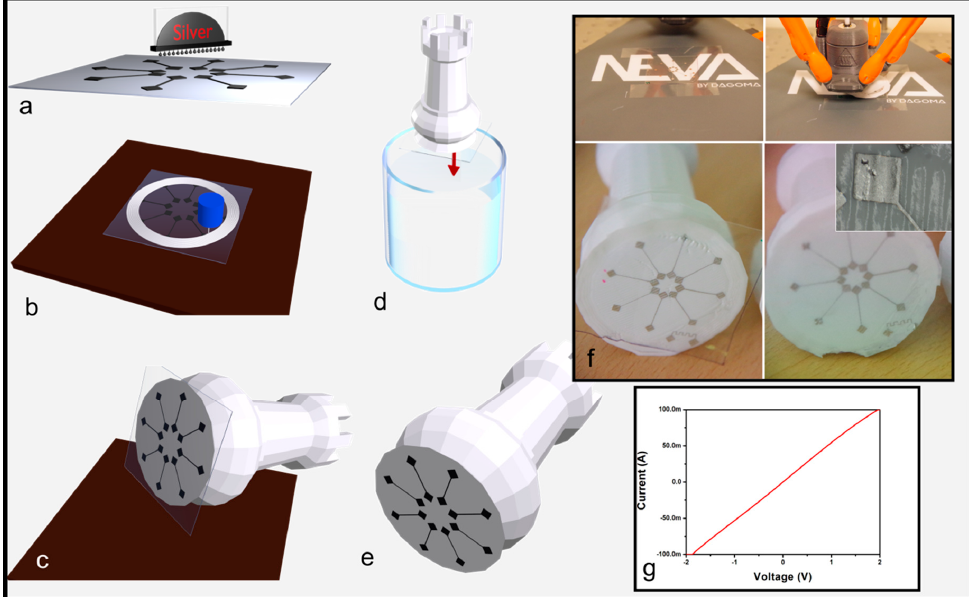
Figure 2. Process variant used to transfer interconnects onto 3D objects additively manufactured.